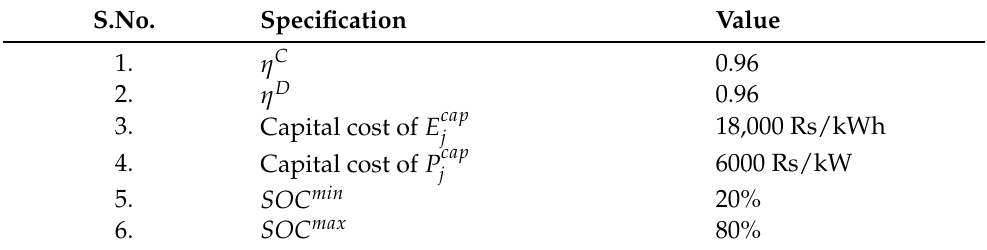
Table 2. DESS and CESS specification.